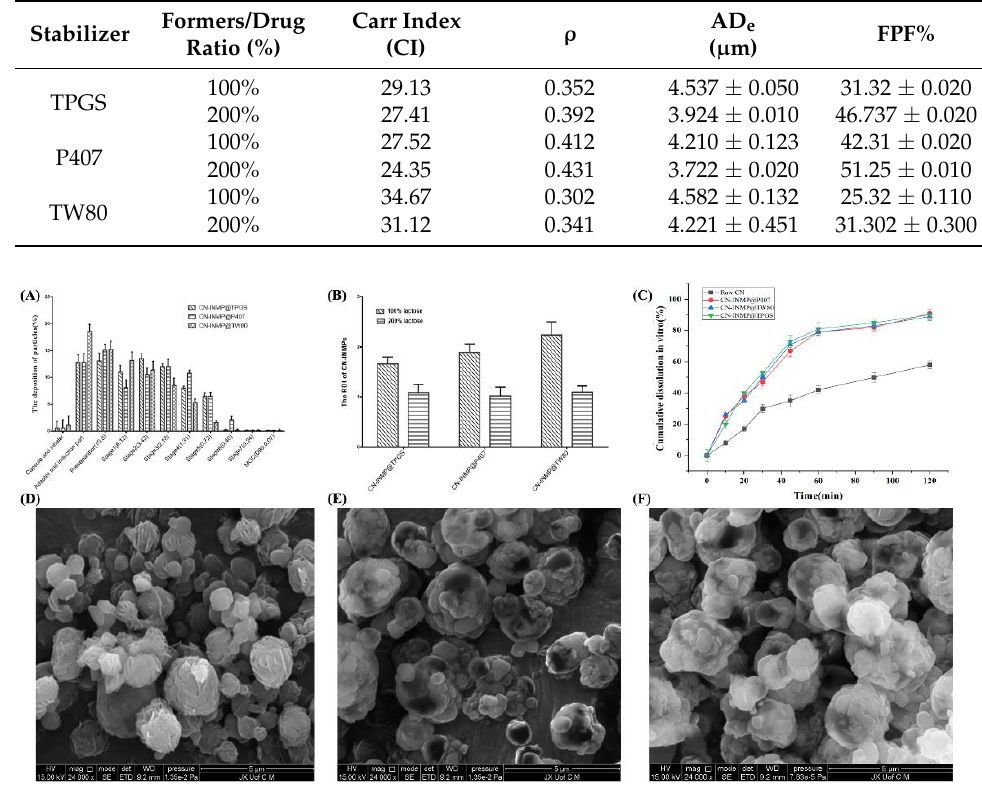
Figure 6. the lung deposition property ( A ), redispersibility index ( B ), the cumulative dissolution ( C ) and morphology of CN-INMP@TPGS ( D ), CN-INMP@P407 ( E ), and CN-INMP@TW80 ( F ).